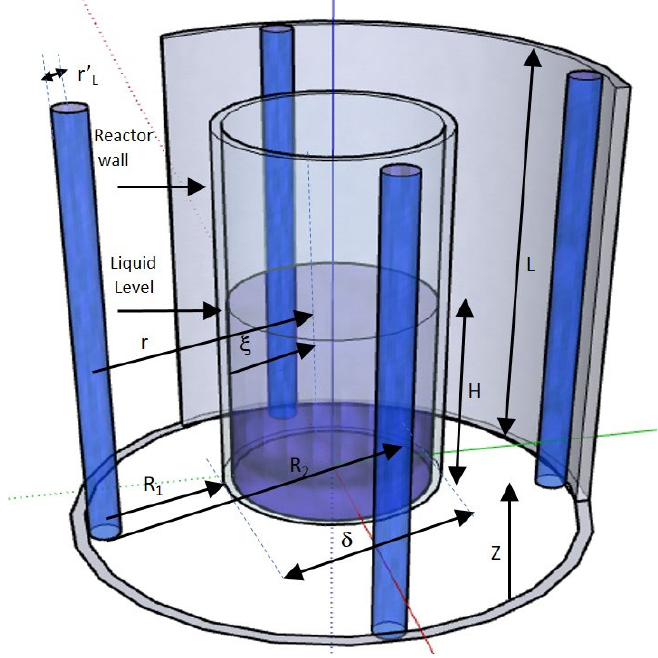
Figure 2. Scheme of the external four lamps photoreactor and principal dimensions.